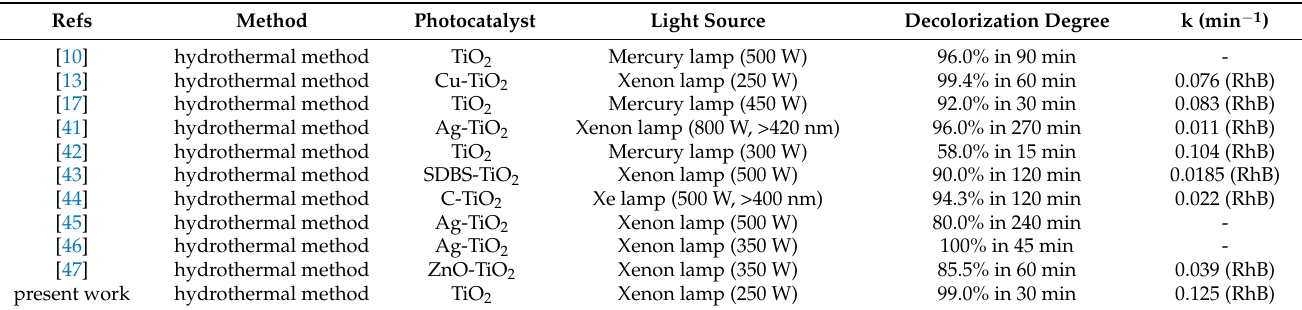
Figure 8. The TC degradation curves ( a ) and the kinetics fitting curves ( b ) of samples. (catalyst 0.1 g, TC solution 100 mL (30 mg/L) and neutral pH).